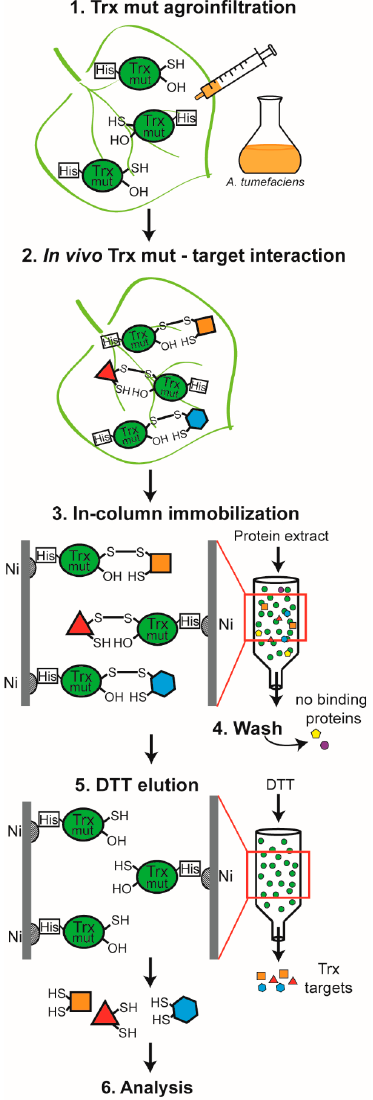
Figure 1. Procedure for isolation of in vivo Trx interactors. His-tagged single-cysteine mutants of Trx f, Trx m and NTRC were separately agroinfiltrated into N. benthamiana plants (1 and 2). After 5 days, leaf protein extraction was performed and the Trxs, along with their interactors, were captured in a column packed with Ni-NTA agarose (3). Finally, redox interactors were eluted with DTT (5). Trx mut: thioredoxin mutant; DTT: